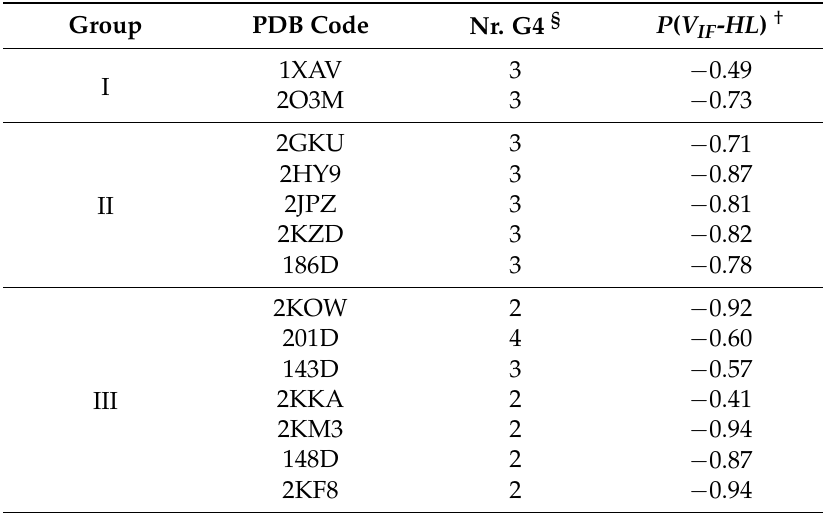
Table 1. Summary of the computed structures and electronic